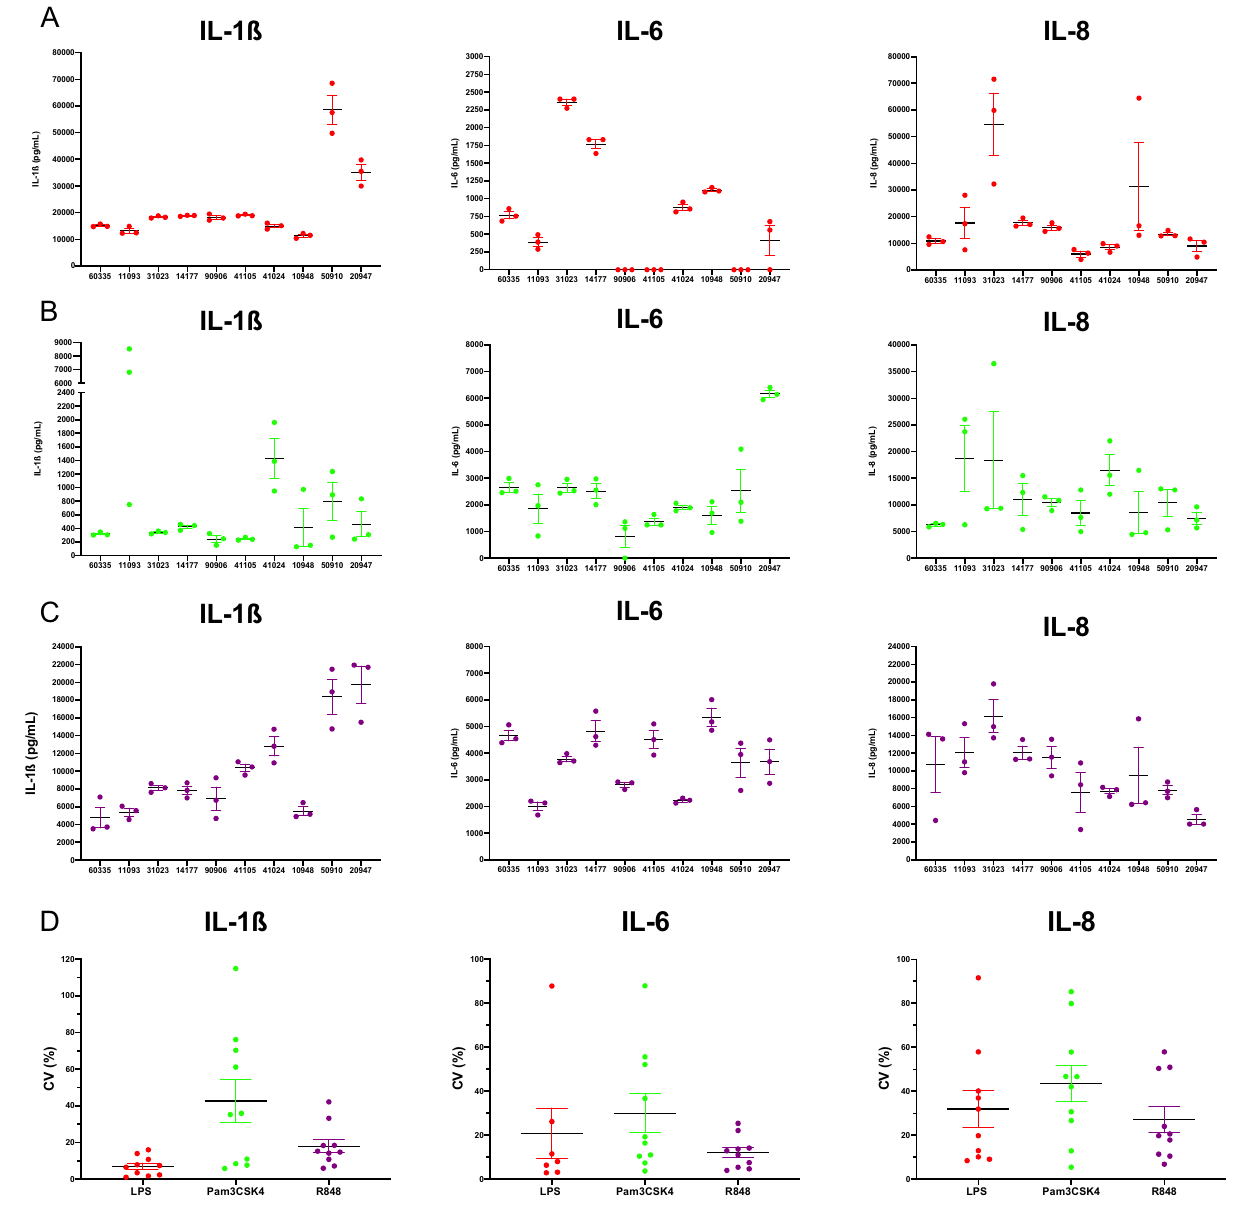
Figure 7. Technical variation of IChek stimulations. Individual induced responses of ten animals to ( A ) 2 µg/ mL of LPS (red), ( B ) 1 µg/mL of Pam3CSK4 (green) ( C ) or 0.2 µg/mL of R848 (purple), with each stimulation carried out three times for each animal at the same time (technical replicates). Protein expression IL-1β, IL-6 and IL-8 in the supernatant of the IChek stimulations after 24 hr incubation, measured using ELISA and reported as in pg in 1 mL of blood, were used as immune readouts. ( D ) Coefficients of variation (Standard deviation/mean*100) were calculated for each immune readout between each animals technical replicates to assess the technical variation. Results were graphed using Prism software (v9.1) (www. graph pad.